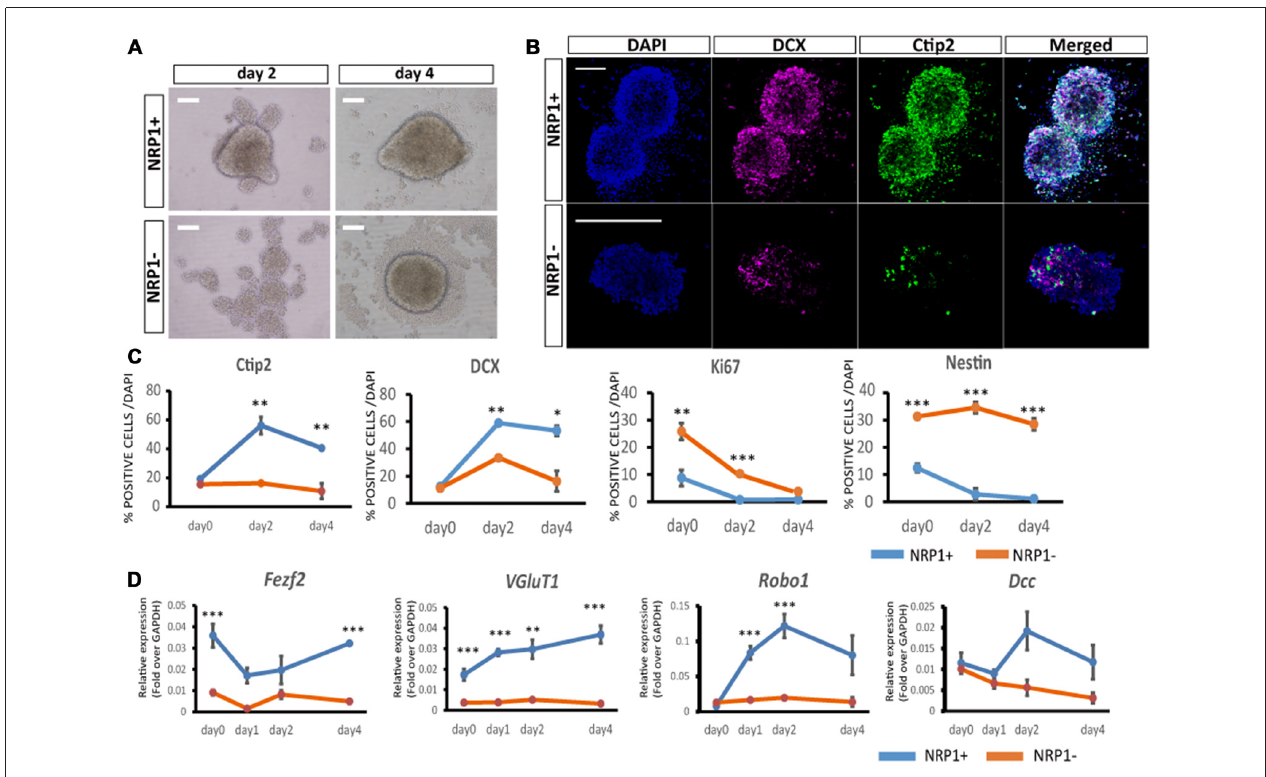
FIGURE 3 | Characterization of aggregates by immunostaining. (A) Bright-Field images of NRP1 + and NRP1 − aggregates on days 2 and 4. Scale bars, 100 µ m. (B) Immunostaining of day 2 NRP1 + and NRP1 − aggregates. Doublecortin (DCX; magenta)/Ctip2 (green)/DAPI (blue). Scale bars, 100 µ m. (C,D) Time course analysis of immunostaining for (C) Ctip2, DCX, Ki67 and Nestin positive cells as a percentage of total DAPI stained cells on days 0, 2 and 4. (D) Time course qPCR analysis of days 0, 1, 2 and 4 aggregates. Values are the mean ± SEM. ∗ p < 0.05, ∗∗ p < 0.01 and ∗∗∗ p < 0.001 by one way ANOVA ( n = 3 independent